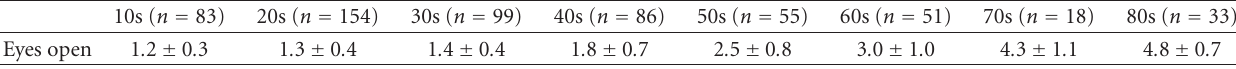
Table 1: Two-point discrimination distances by age group.